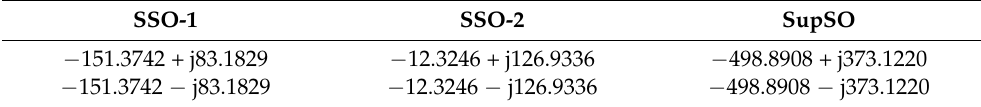
Table 3. The eigenvalues of the modes after order reduction.